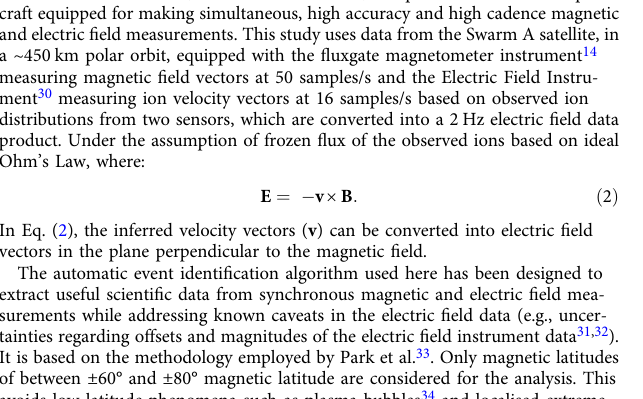
with respect to the Earth ’ s rotation axis, causing effective inter- hemispheric differential solar illumination of the two auroral ovals. This effect may also be present on other magnetised planets or moons where the magnetic dipole is offset from the planet ’ s centre, asymmetries in MIC occurring as a result of the impacts of differential ionospheric conductivity.